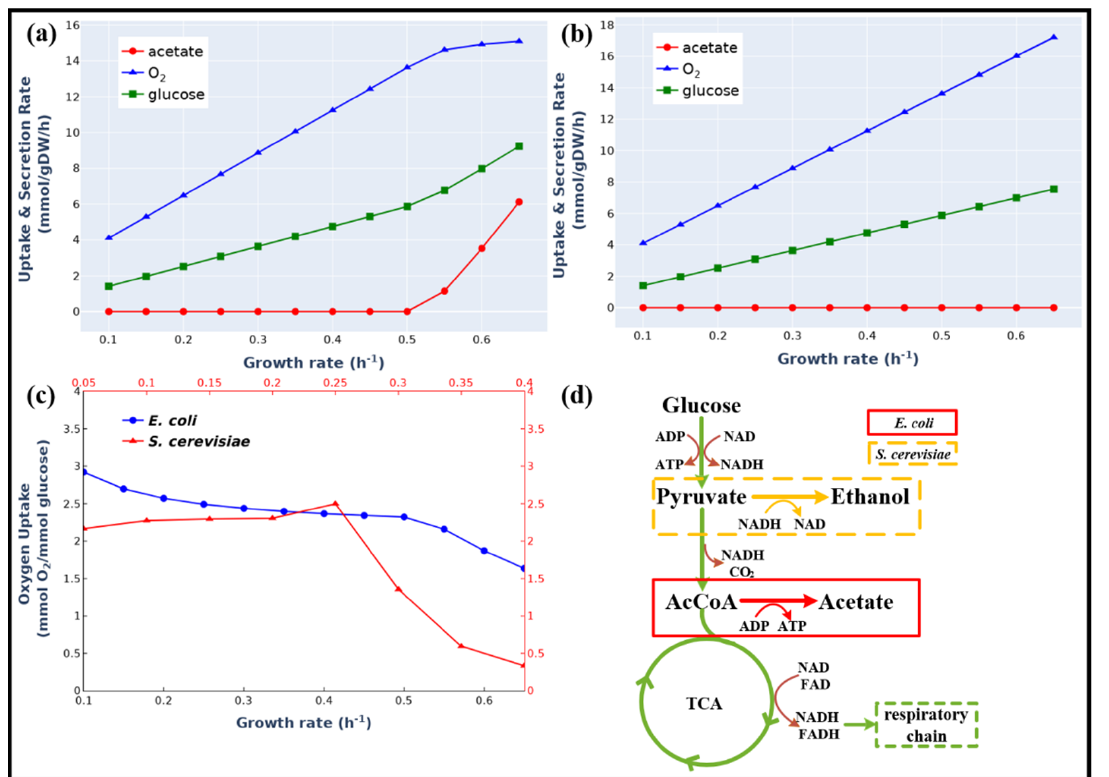
Figure 3. Comparison of Simulation Results of the Enzyme-constrained Model ec i ML1515 and the Stoichiometric Model i ML1515. Simulation of overflow metabolism at different growth rates using ec i ML1515 ( a ) and i ML1515 ( b ). ( c ) Simulated different overflow metabolism of E. coli and S. cerevisiae . ( d ) The different overflow metabolic pathways of E. coli and S. cerevisiae .